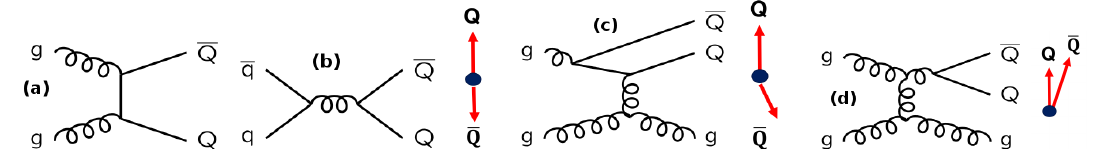
Figure 1. Charm production mechanisms: ( a ) gluon fusion, ( b ) quark annihilation, in the pair production (LO), the heavy quarks are back to back at 180 ◦ , ( c ) flavor excitation (NLO), the heavy quarks have a large opening angle, ( d ) gluon splitting (NLO), the heavy quarks have a very small opening angle [1].